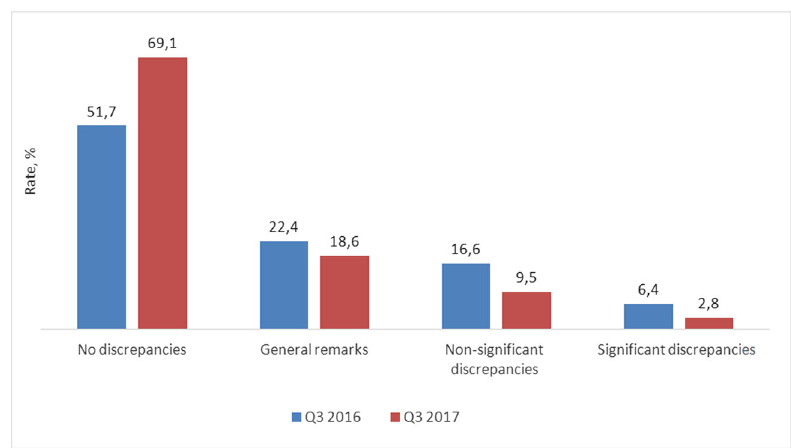
Fig. 1 The effectiveness of a telemedicine-based quality assur- ance system: the rate (%) of the discrepancies and the correct ra- diologic reports before (Q3 2016) and after (Q3 2017) the imple- mentation of the